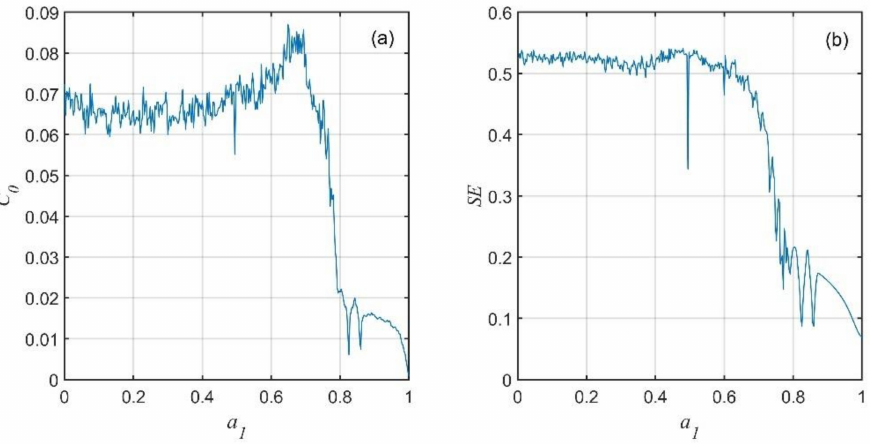
Figure 3. Complexity of system (14) with a 1 varying from 0 to 1 for q = 0.95. ( a ) C 0 complexity; ( b ) SE